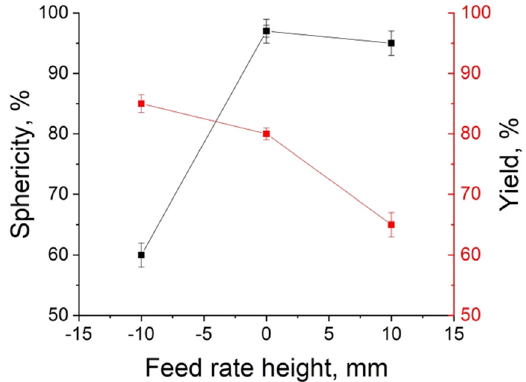
Figure 7: The dependence of the sphericity and the percentage yield of the powder from the feed rate